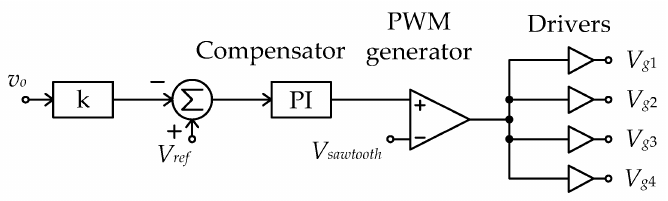
Figure 8. The control diagram of the proposed bridgeless high step-up voltage gain PFC converter.